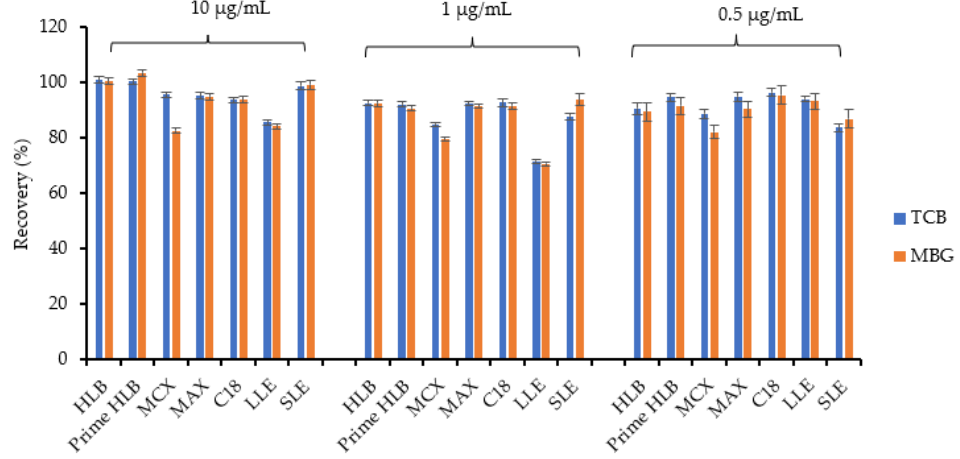
Figure 4. Percent recoveries of CTSs spiked in H 2 O determined by HPLC-PDA after extraction with various extraction methods. The HPLC-PDA analyses were carried out in triplicate ( n = 3).